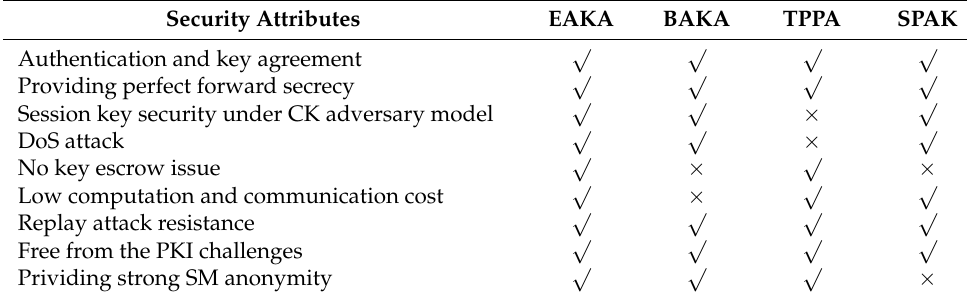
Table 2. Feature-based comparison with the related schemes. Security